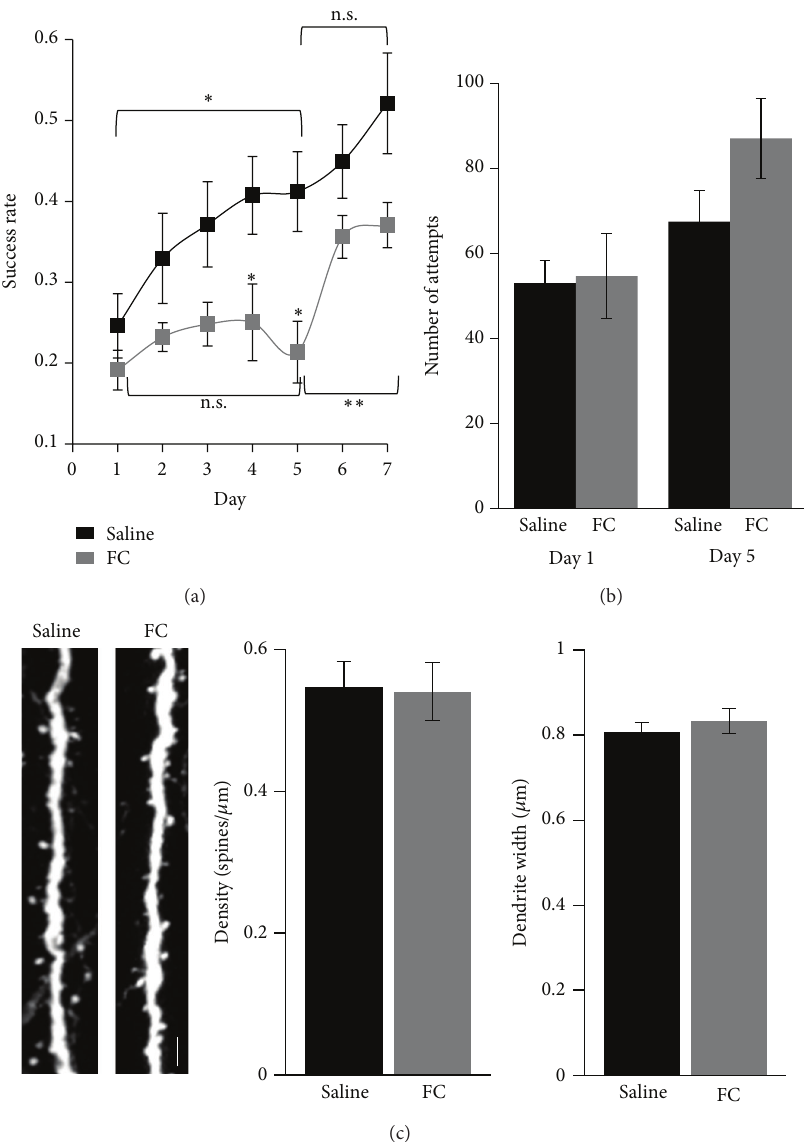
Figure 2: Astrocytic activity is necessary for motor skill learning. (a) Motor skill learning curves for saline and FC injected mice. Two-way ANOVA revealed a significant effect with training ( 𝑃 = 0.0001 ) and treatment ( 𝑃 < 0.0001 ). FC injected mice show a deficit in motor skill learning that is rescued by D-serine on days 6 and 7. (b) No difference was detected between number of reaching attempts made on day 1 and day 5 with FC injection. (c) Representative images of dendritic spines in saline and FC injected conditions. Scale bar: 3 𝜇 m. FC injection does not alter the dendrite width and spine density. ∗ 𝑃 < 0.05 and ∗∗ 𝑃 < 0.01